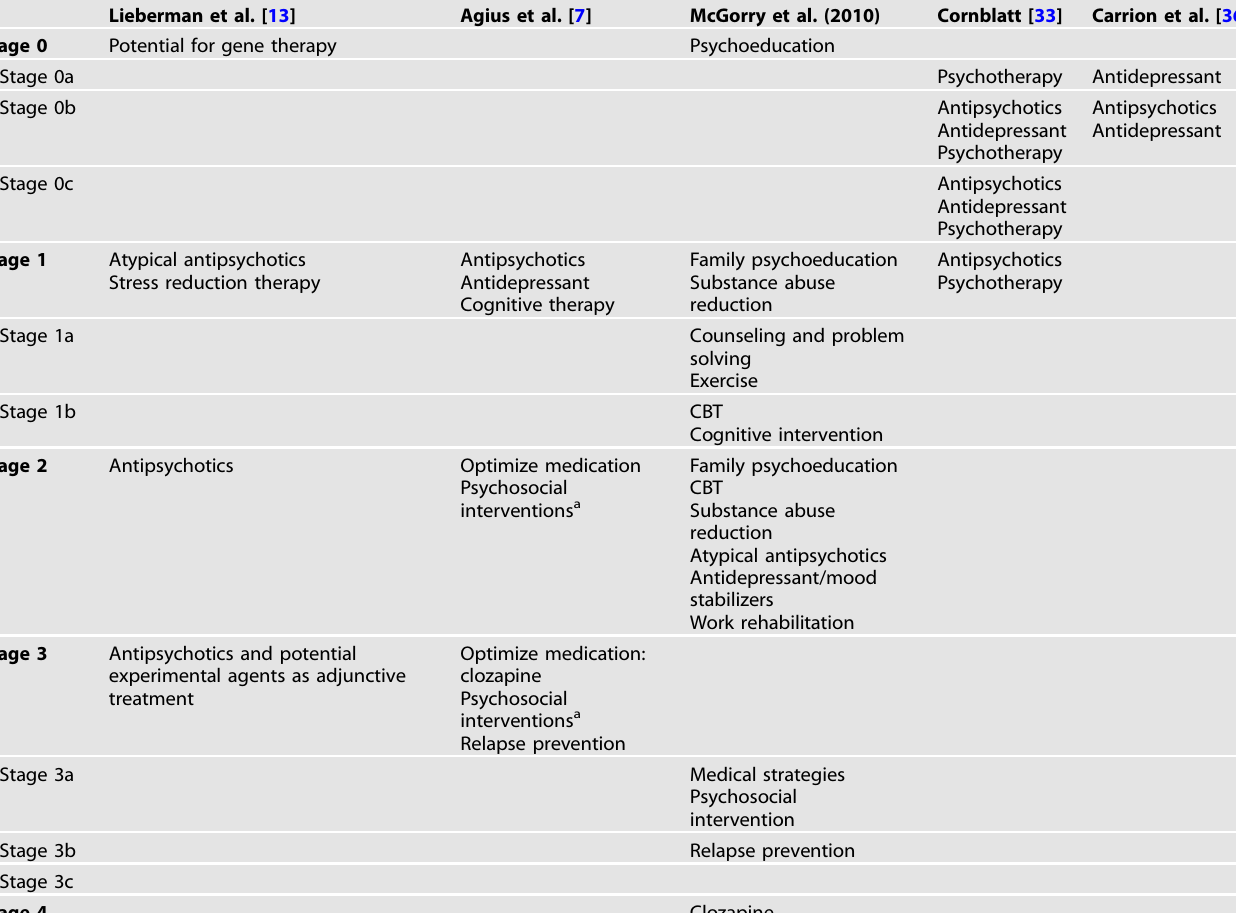
Table 3. Interventions proposed by stages.